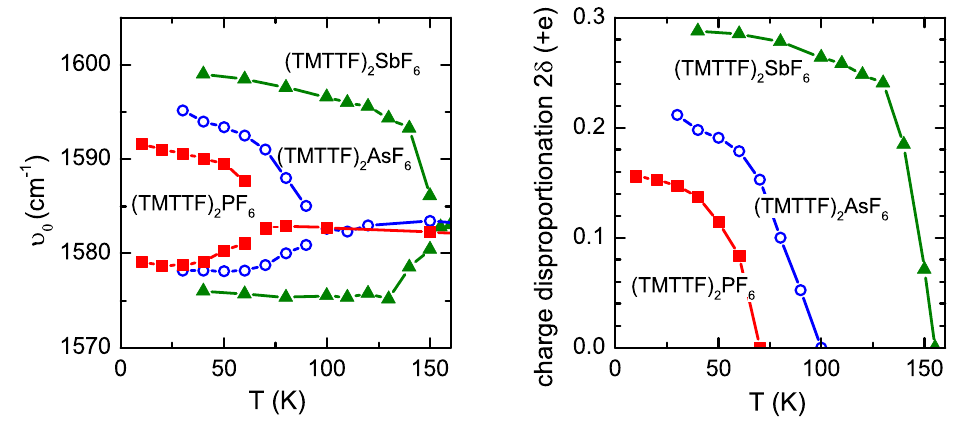
X with X = SbF − , AsF − and PF − 2 6 6 6 mode. The charge imbalance 2 δ is 28